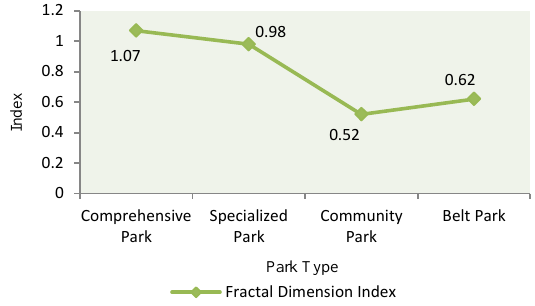
Figure 6. Fractal dimension of park green space in Wuhan main urban